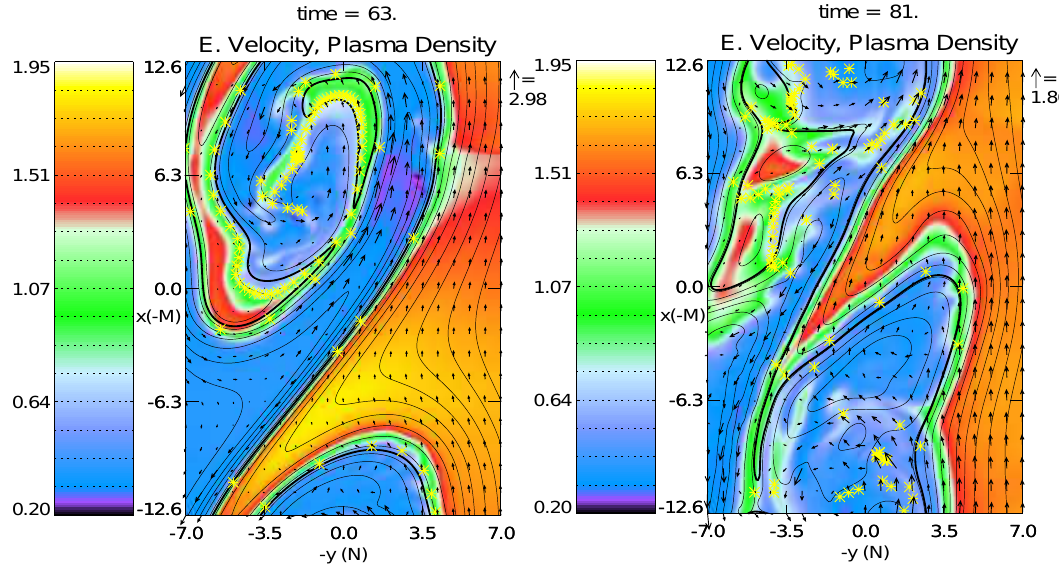
Fig. 3. KH vortex at t/τ A ≈ 63 and at t/τ A ≈ 81. Lines are magnetic field lines projected to x,y -plane and arrows are electron velocity vectors. Color code represents plasma